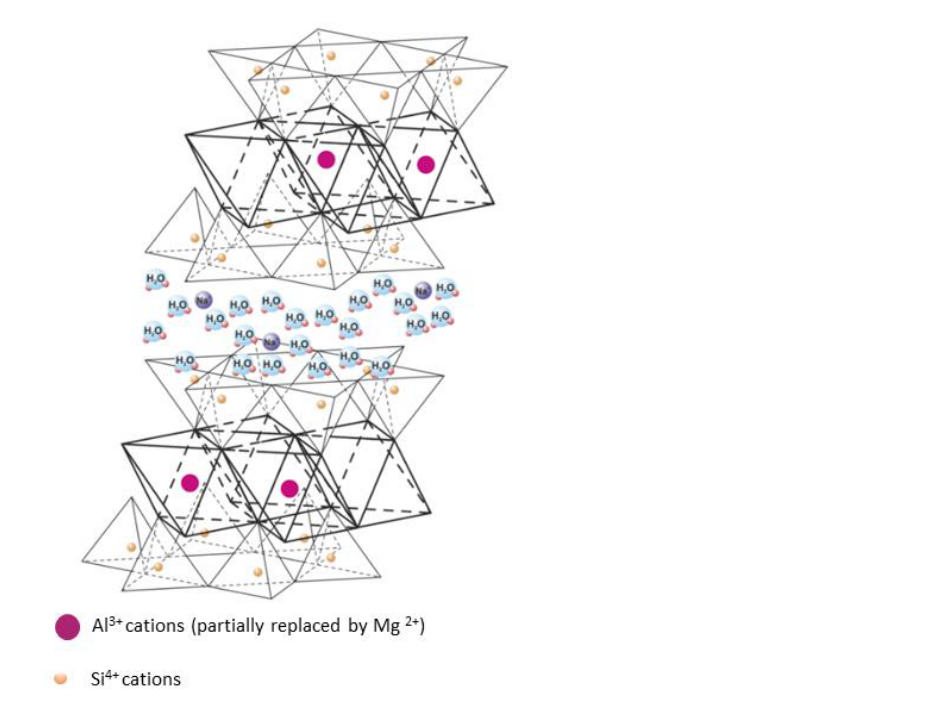
Figure 1. Model structure of montmorillonite. Reprinted with permission from ref. [2]. Copyright 2018 Elsevier.